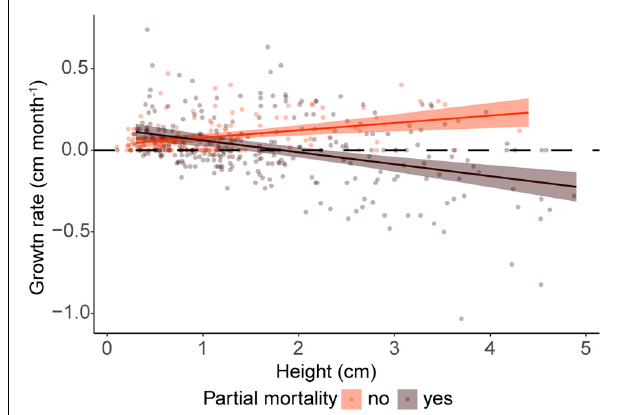
FIGURE 9 | Realized growth rates as a function of height for colonial recruits that suffered (brown) and never suffered (red) partial mortality. The horizontal dashed lined represent no-growth.